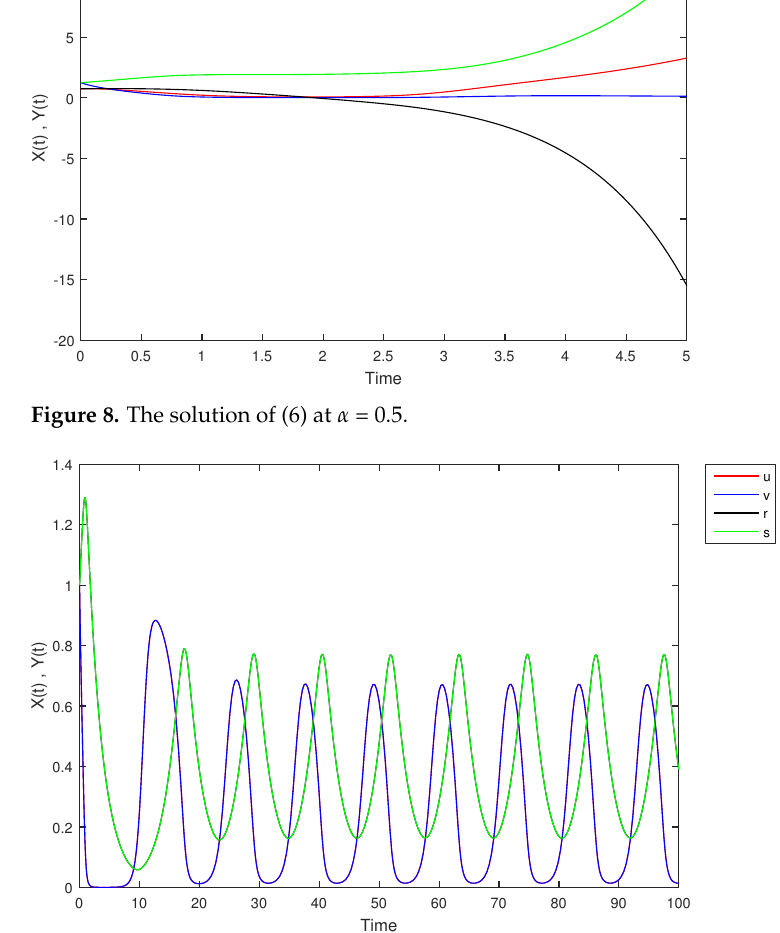
Figure 9. The solution of (6) at α =